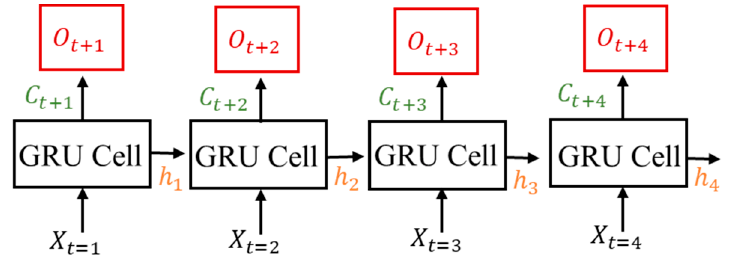
Figure 6. Illustration of GRU in our proposed framework.